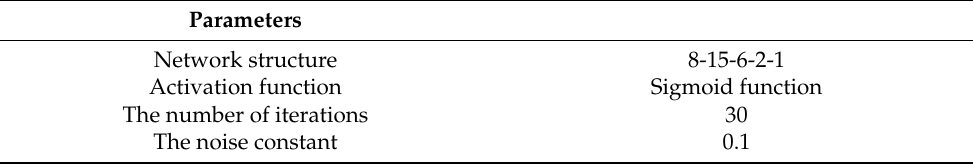
Table 2. Experimental parameters of the stacked